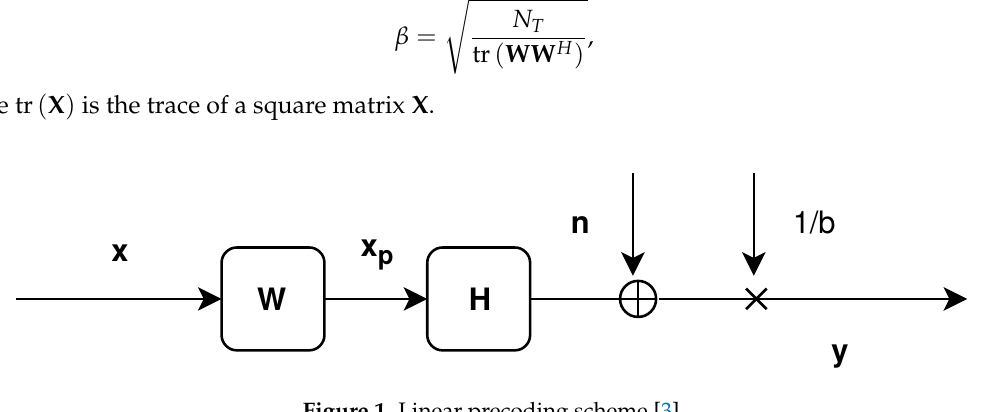
Figure 1. Linear precoding scheme